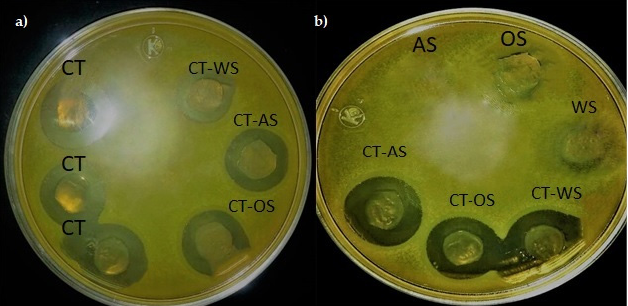
Figure 4. Inhibition halos of edible films based on starch, CH and CH ‐ starches mixtures (1:3 ratio, w / w ) against Listeria innocua. CT: Chitosan; OS: Oxidized starch; AS: Acetylated starch; WS: Waxy starch. ( a ) CT versus CT ‐ starch mixtures; ( b ) Starches versus CT ‐ starch mixtures.